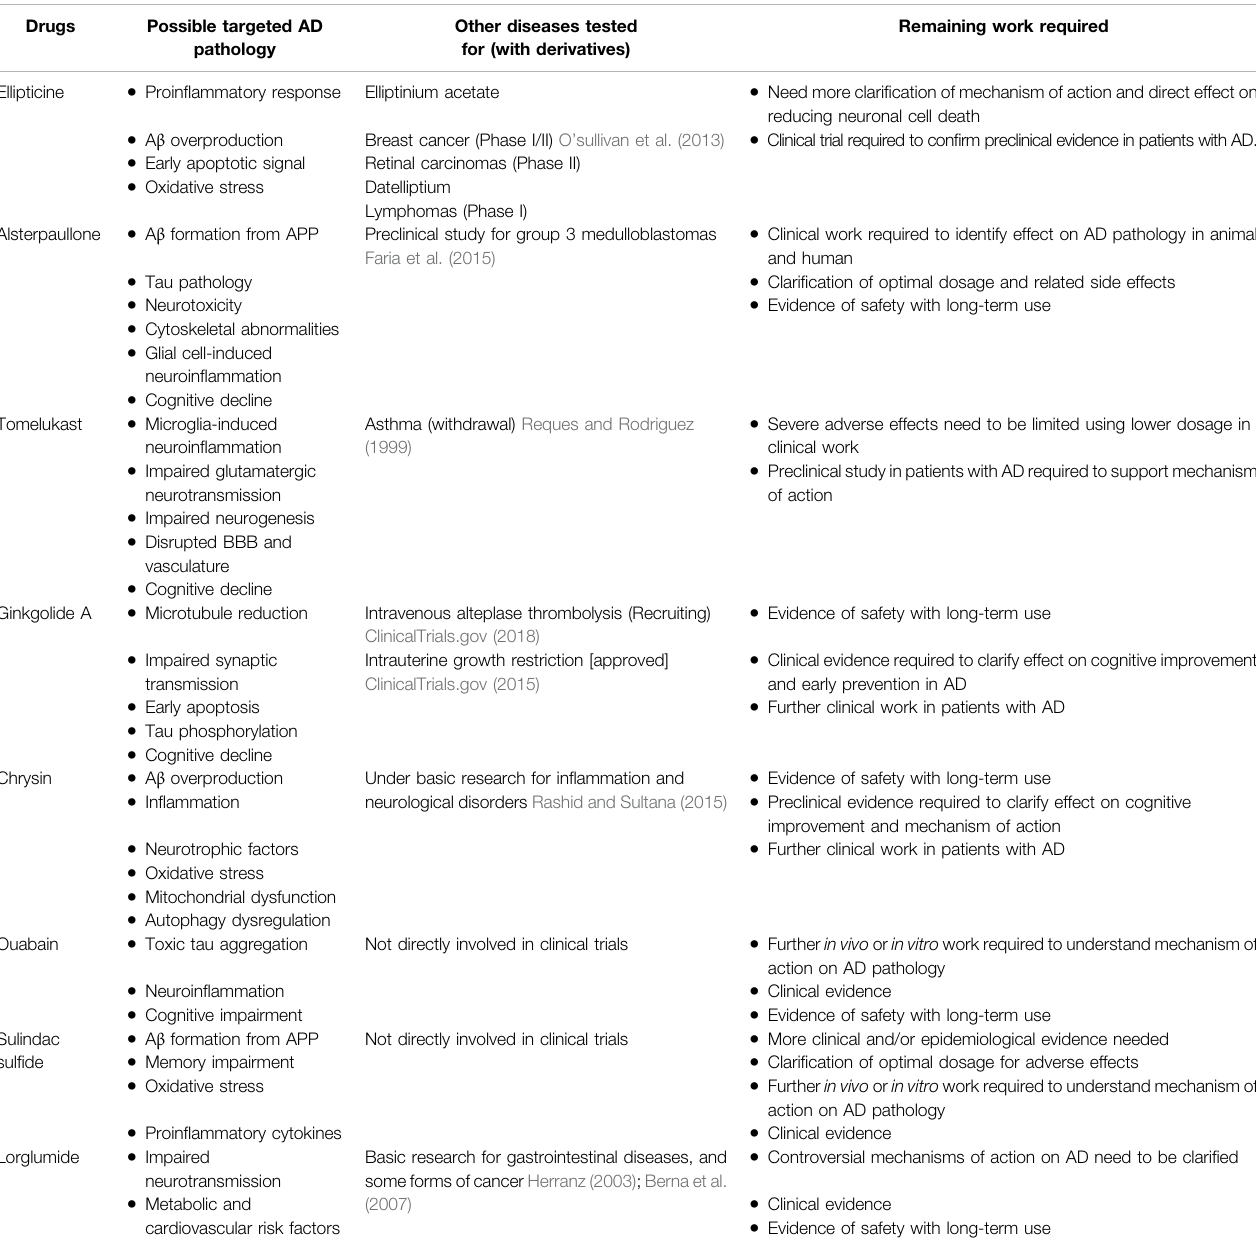
TABLE 3 | Clinical trial/Preclinical research summary for AD candidate drugs. Drugs Possible targeted AD Other diseases tested pathology for (with